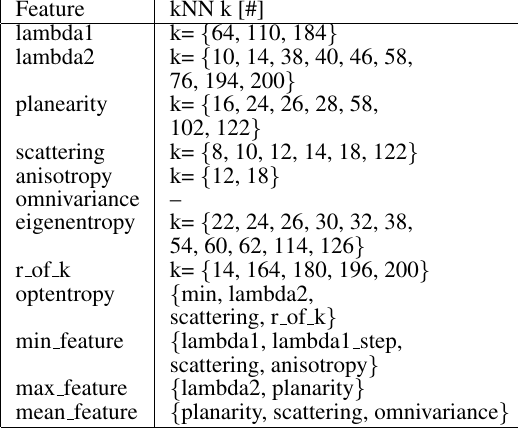
Table 1. CFS Selected Features - kNN